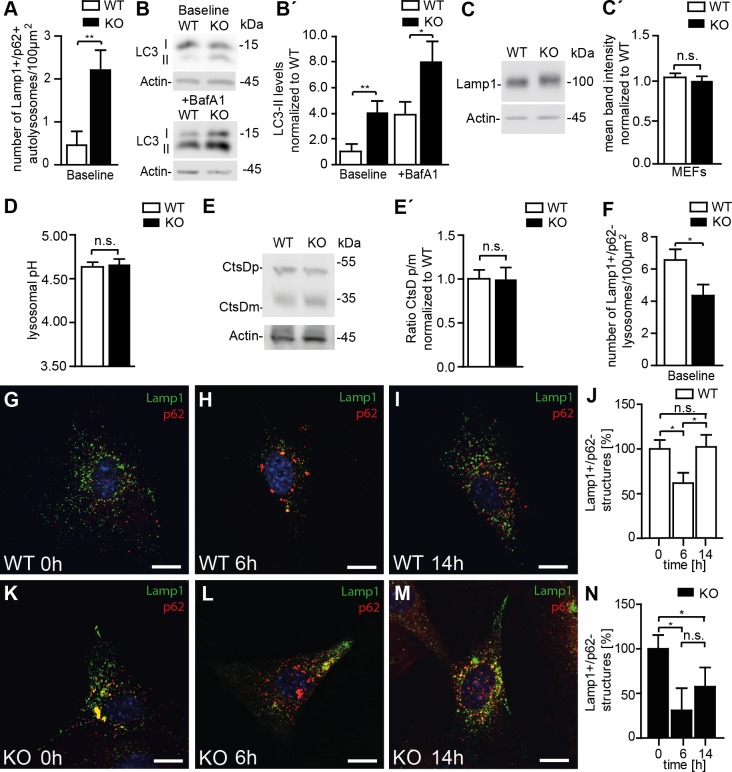
Disruption of Spatacsin decreases the regeneration of lysosomes in KO MEFs.
(A, G, K) Autolysosomes defined as vesicles that stain for both Lamp1 and p62 are increased in KO compared to WT MEFs (Mean±SEM of n = 3 experiments; Student’s t-test: ** indicates p<0.01). (B, B´) LC3-II levels are increased in KO MEFs and further increase after treatment with bafilomycin A1. Quantification of LC3-II levels normalized to actin in MEFs (Mean±SEM of 4 independent experiments; Student´s t-test: ** indicates p<0.005 and * p<0.05). (C, C´) Overall Lamp1 levels are not changed in MEFs isolated from Spatacsin KO mice (Mean±SEM of n = 3 independent experiments; Student’s t-test: n.s. indicates not significant). (D) The intralysosomal pH is not changed in KO MEFs (Mean±SEM of n = 3 experiments with more than 1,000 lysosomes. Student’s t-test: n.s. indicated not significant). (E, E´) Lysosomal processing of the lysosomal protease Cathepsin D (CtsD) is not impaired in KO MEFs (CtsDp: precursor; CtsDm: mature). Mean±SEM of n = 4 independent experiments; Student’s t-test: not significant (n.s.). (F) Lysosomes defined as vesicles positive for Lamp1 but negative for p62 are decreased under baseline conditions in Spatacsin KO MEFs. (n = 3 experiments; Student’s t-test: * indicates p<0.05). (G-N) Upon 6 h of starvation lysosomes were depleted in both WT and KO MEFs. After 14 h lysosome numbers recovered to baseline levels only in WT (Mean±SEM of n = 3 experiments; Student’s t-test: * indicates p<0.05). Scale bars: 10μm.